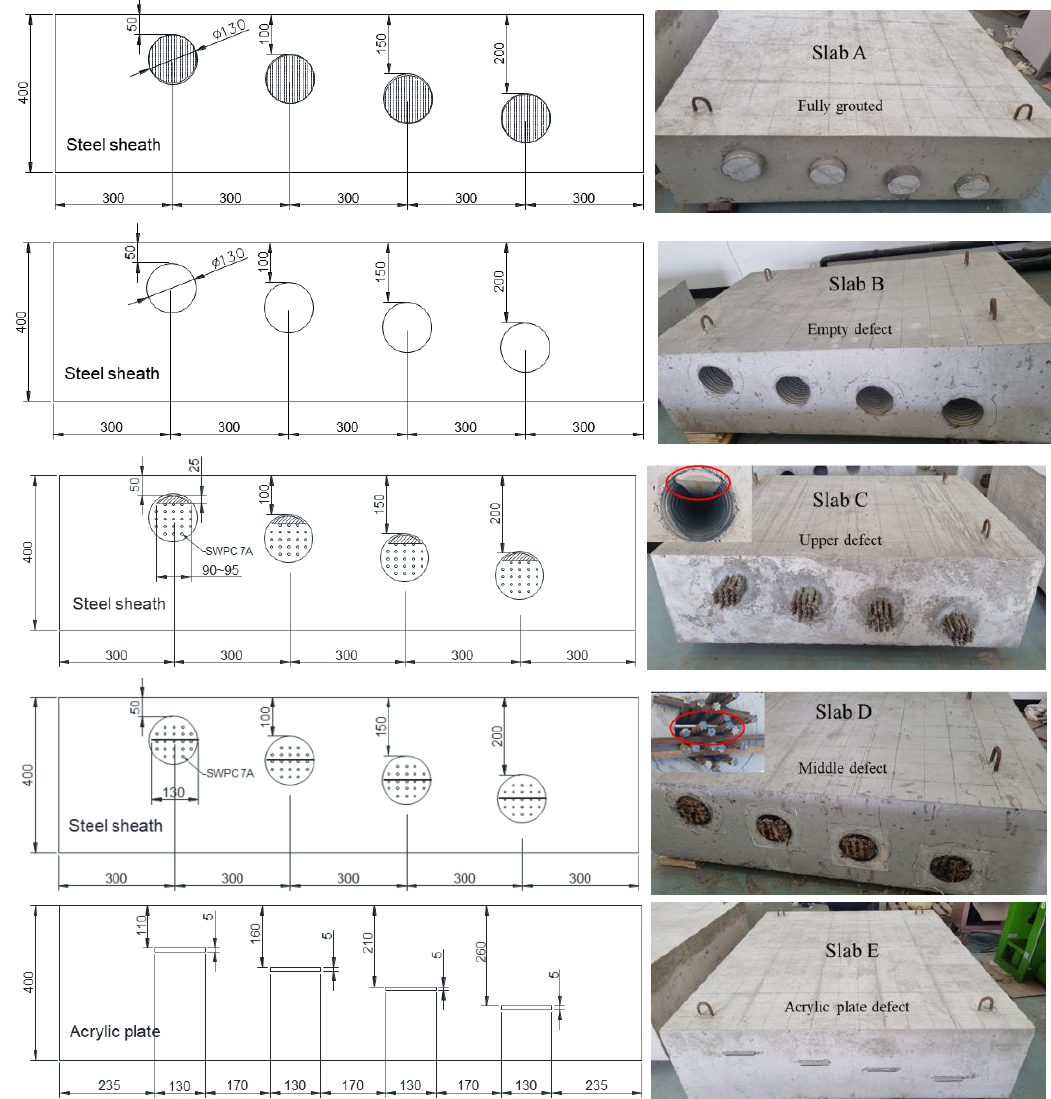
Figure 1. Cross-sectional dimensions (in mm) and manufacturing results of the tested concrete